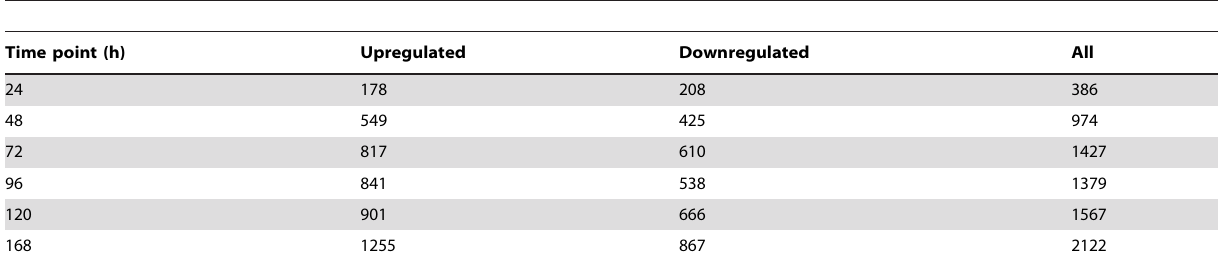
Table 3. Number of DEGs at each time point during ESC differentiation as compared with the starting point (0 h after EB formation).